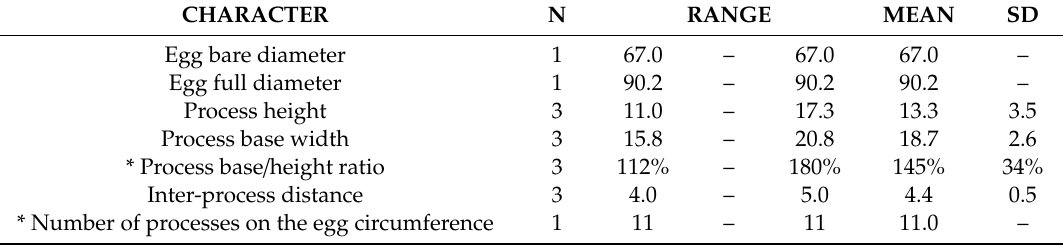
Table 10. Measurements (in µ m) of selected morphological structures of egg of the Italian population of Paramacrobiotus fairbanksi Schill, Förster, Dandekar and Wolf [25] mounted in Hoyer’s medium (N, number of eggs / structures measured; RANGE refers to the smallest and the largest structure among all measured eggs; SD, standard deviation). * except of values of ratio which is presented as percentage and number of processes on the egg circumference which is as number.